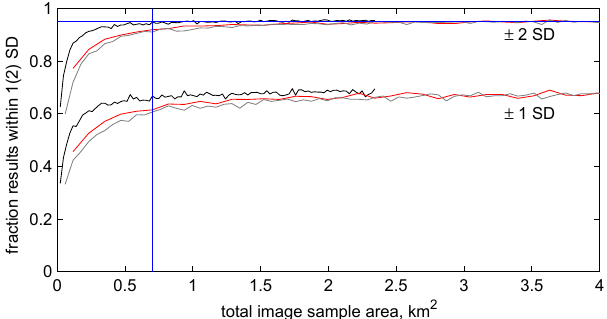
Figure 11. Fraction of image subset-based aggregate albedo values within the interval of ± 1 and ± 2 SD of the bootstrap estimated regional albedo as a function of total image (sample) area. The sub- sets are formed of image blocks of length 1 (black), 10 (red) and 25 (grey) images. The solid blue lines highlight the 0.95 fraction and 0.7km 2 aggregate scale for subsets formed of single image